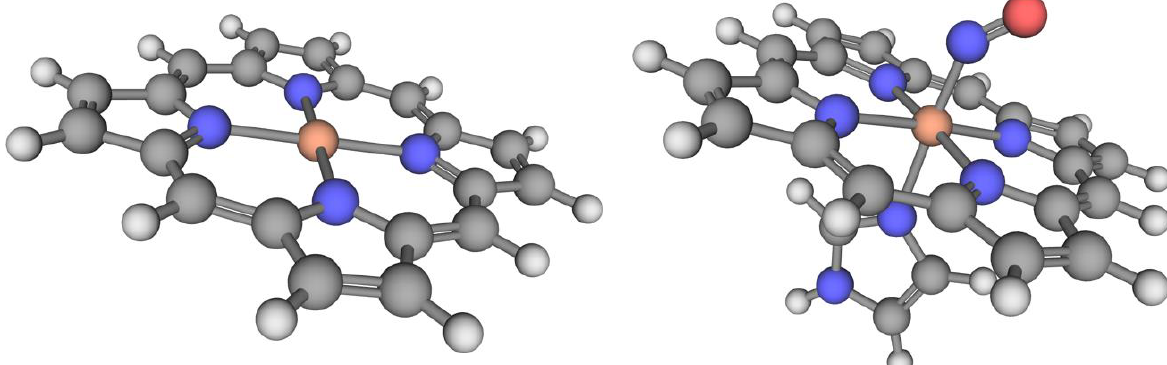
Figure 3. ( Left ) One of the iron-porphyrin rings (FeP) in the PorSS11 dataset. ( Right ) The porphyrin- imidazole-NO complex (FePIm-NO) from the PorBE10 dataset. The imidazole ring is used in place of the full heme active site. Hydrogen atoms are white, carbon atoms are black, nitrogen atoms are blue, the oxygen atom is red, and the iron atom is orange.